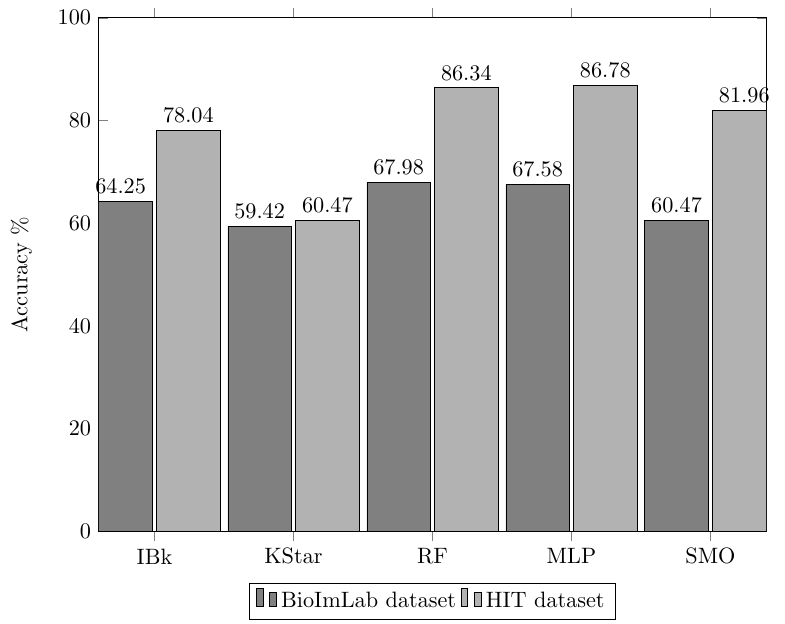
Figure 6. accuracies using 10 Q-band images.